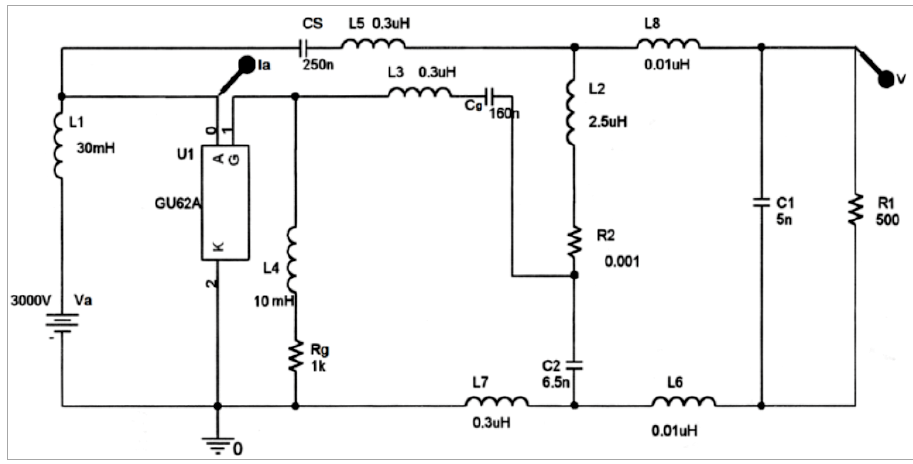
Figure 3. Graph of the dependence of anode current and grid current on grid voltage at constant anode voltage V a = 3000 V.